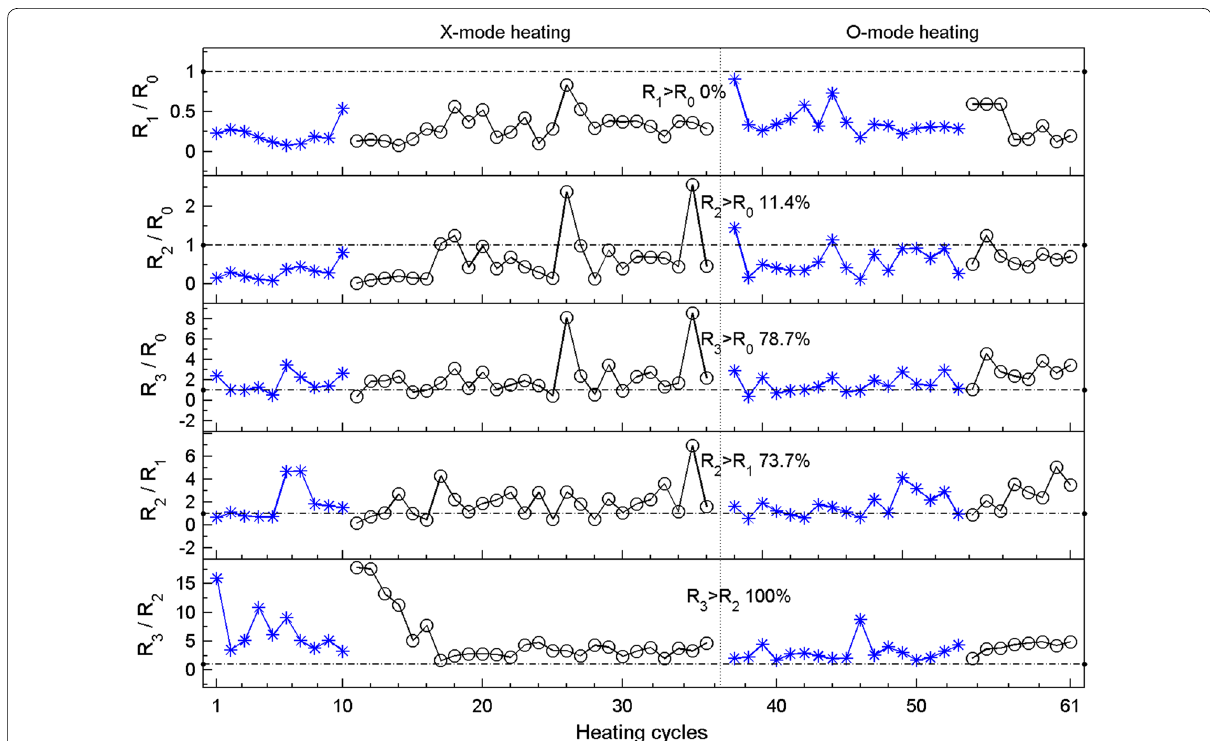
Fig. 3 The distributions of ratios of different parameters R 0 , R 1 , R 2 and R 3 for case 1 of Table 1. In each panel, the horizontal dashed-dotted line indicates when the ratio is equal to 1. The asterisks represent the measurements at transmitter frequency 5.423 MHz, whereas the circles represent the measurements at 7.953 MHz. The vertical dash line is used to separate the measurements of X- and O -modes